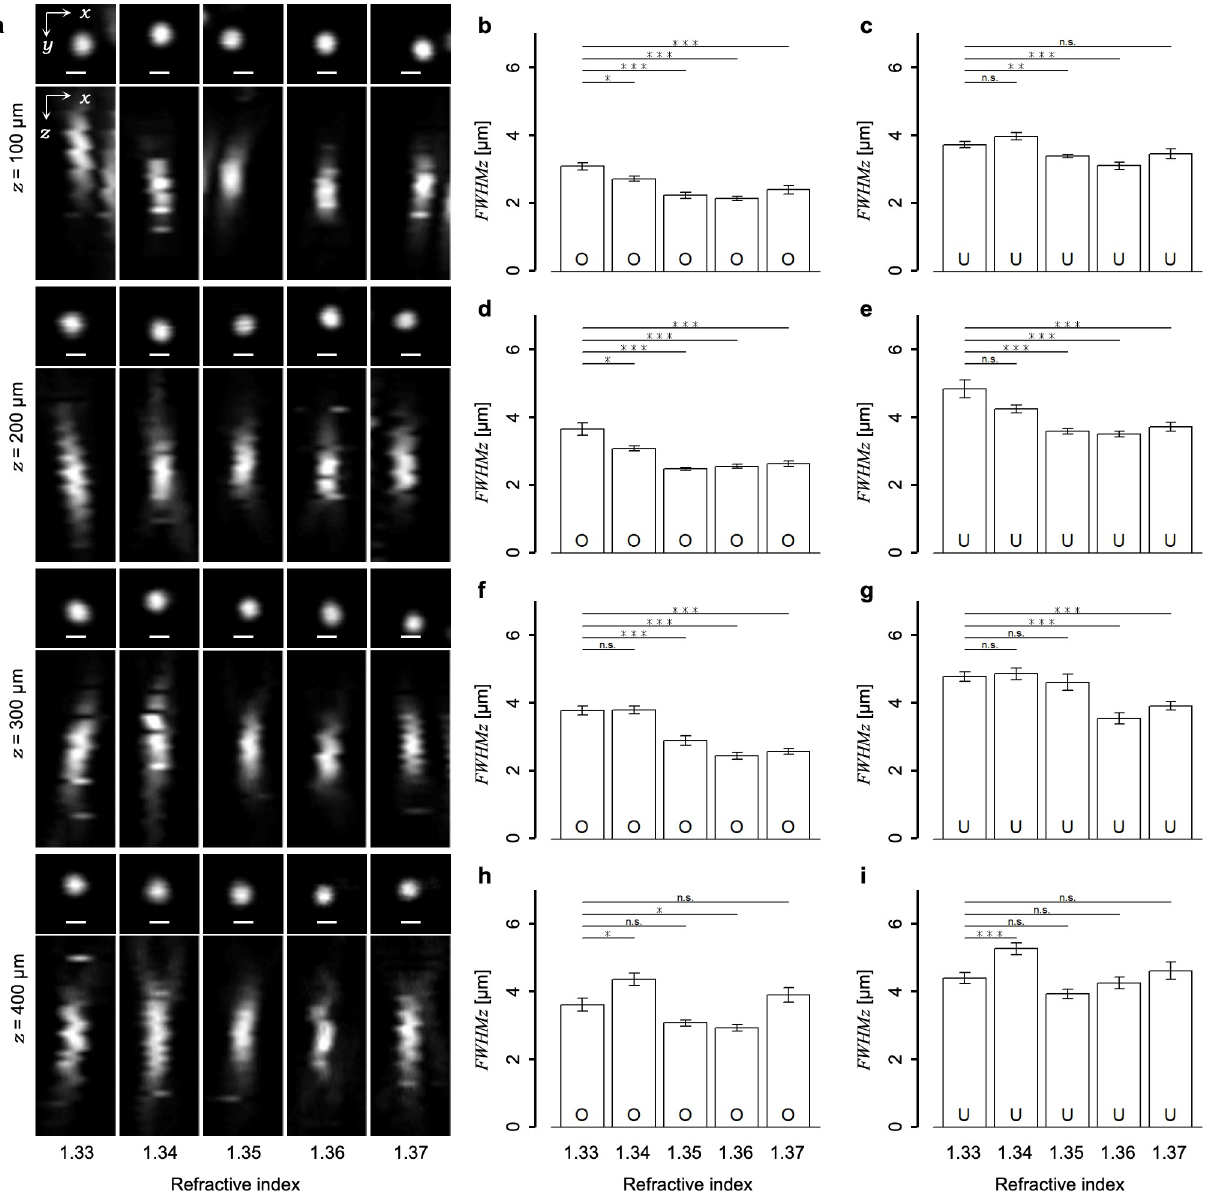
Fig 3. Effects of the RI modulations on the focal volume in living mouse brains. (a) Typical fluorescent microbead images obtained at each value of the RI in the immersion liquid (1.33, 1.34, 1.35, 1.36, and 1.37) and each depth (100, 200, 300, and 400 μ m) under the overfill condition. The x–y images show single sections and the x–z images show max intensity projections. The fluorescence intensities were normalized. All scale bars represent 1 μ m. (b– i) The averaged FWHMs measured from the intensity profiles of the bead images obtained under (b, d, f, h) the overfill and (c, e, g, i) underfill conditions. All statistical tests were carried out at the 1.33 condition with the other RI conditions. O: overfill; U: underfill; � : p < 0.05; �� : p < 0.01; ��� : p < 0.005 (Welch’s t-test with Bonferroni correction). Error bars represent